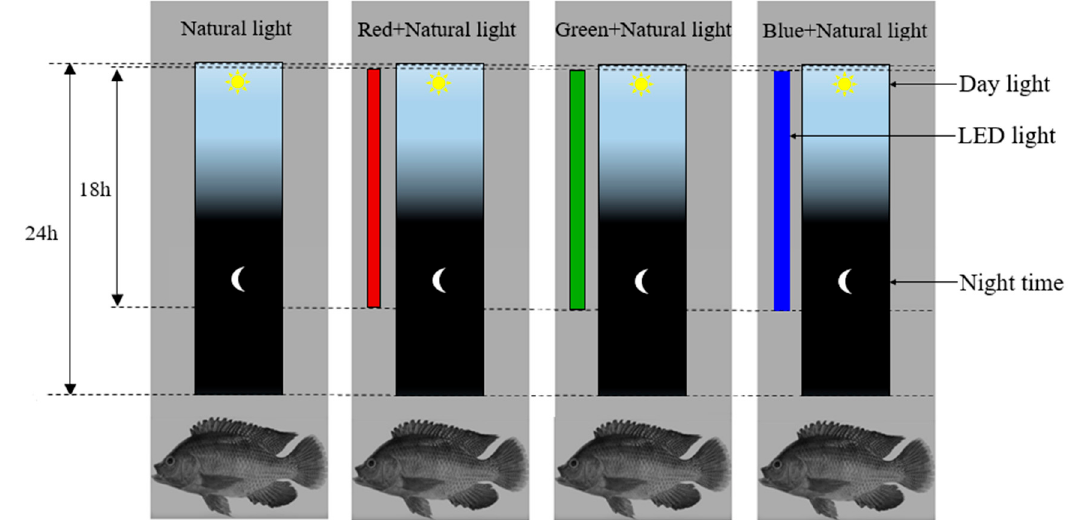
Figure 1. Light periods received by each tank during this research. All treatments received natural light, but three of the treatments were also illuminated with red, green, and blue colored light, which was provided by an LED lamp, with a photoperiod of 18 h per day.